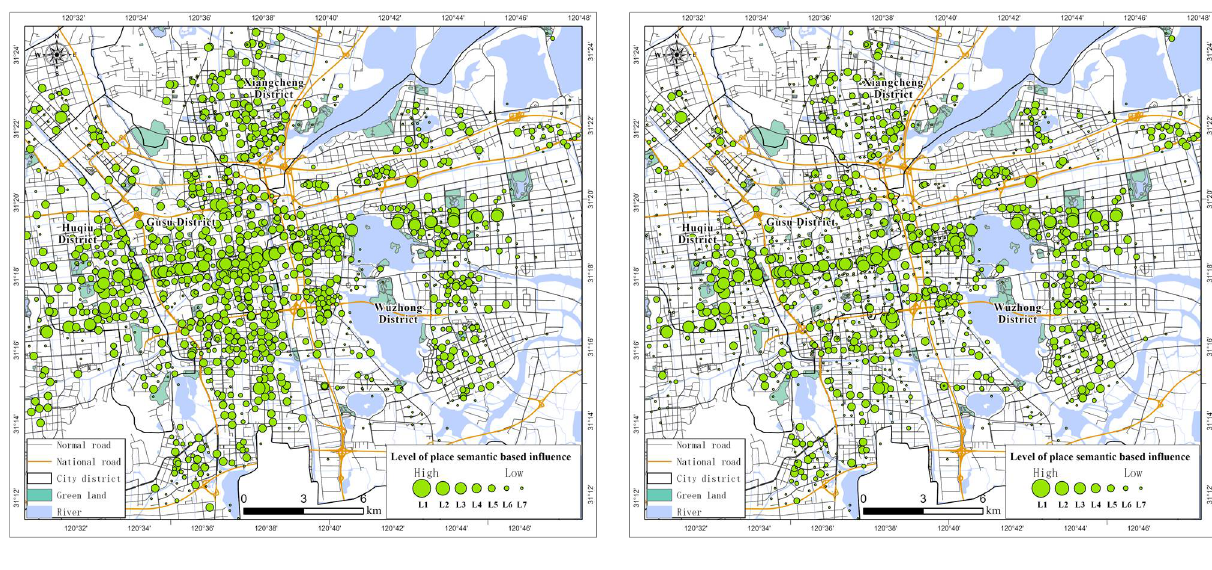
Figure 8. Place semantic-based impact analysis result.